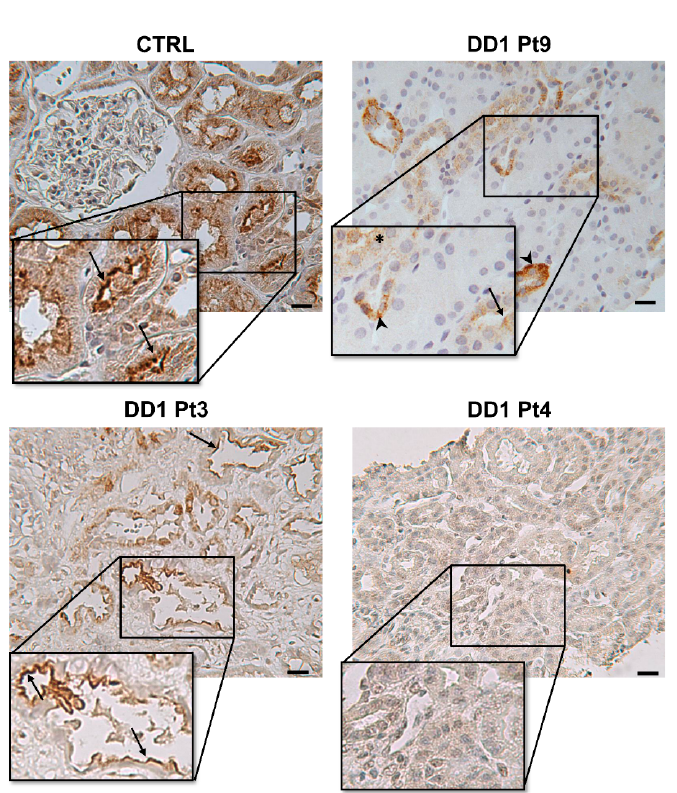
Figure 3. ClC-5 immunolabeling in control and DD1 kidneys. Representative images disclosing ClC-5 positivity in control and DD1 kidneys. In CTRL, ClC-5 staining was located mainly in tubular apical and subapical positions. In DD1 patients, some tubules presented basolateral or cytoplasmic ClC-5 positivity (Pt9), and very few showed apical staining (Pt9, Pt3). ClC-5 immunostaining was negligible in most DD1 tubules (Pt4), whatever the type of mutation. The asterisk indicates a cytoplasmic signal, arrows indicate apical and subapical signals, the arrowhead indicates a basolateral signal. Scale bar = 50 µ m. CTRL = control, Pt =